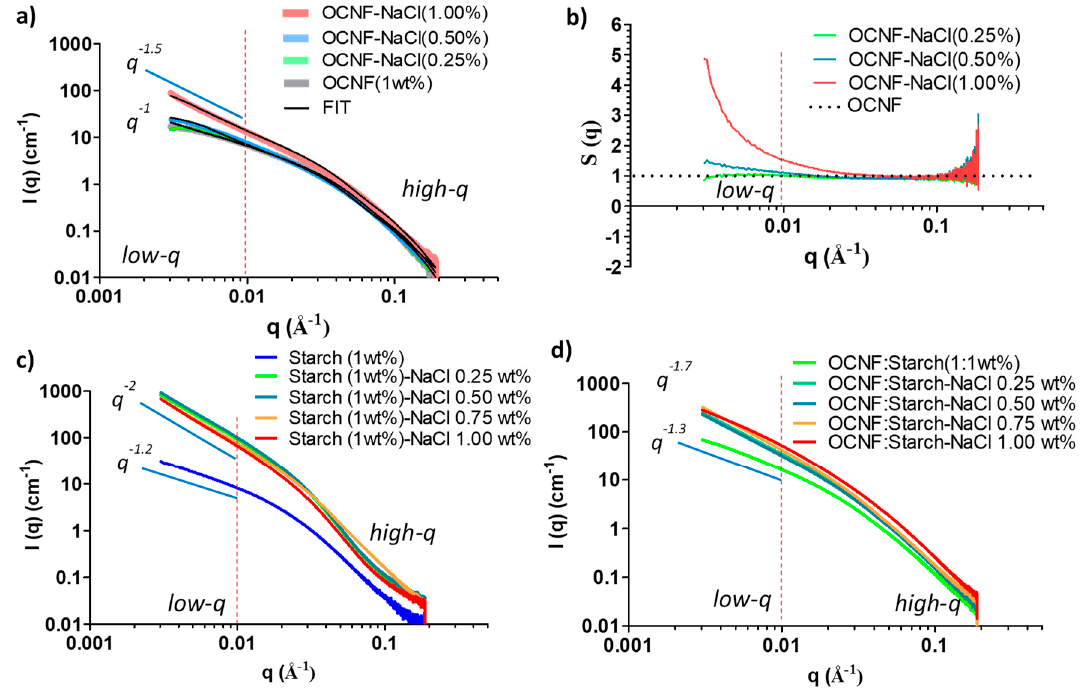
Figure 9. ( a ) SAXS patterns of OCNF (1 wt%) suspensions at various salt concentrations, ( b ) structure factor, S(q) of OCNF/salt gels obtained by dividing the signal of the blend gels by the scattering pattern from an OCNF suspension measured without salt, ( c ) SAXS patterns of starch (1 wt%)/salt, and ( d ) the OCNF:starch (1:1 wt%)/salt systems.